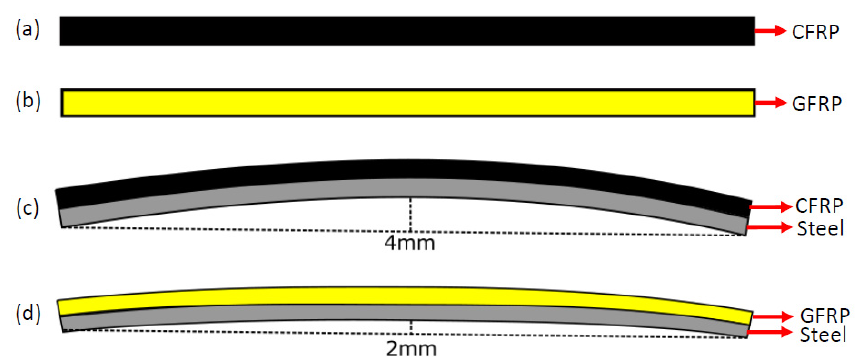
Figure 13. Schematic highlighting relevant values related to warpage of the fabricated samples after removal from the tool ( a ) CFRP, ( b ) GFRP, ( c ) CFRP/steel and ( d ) GFRP/steel.